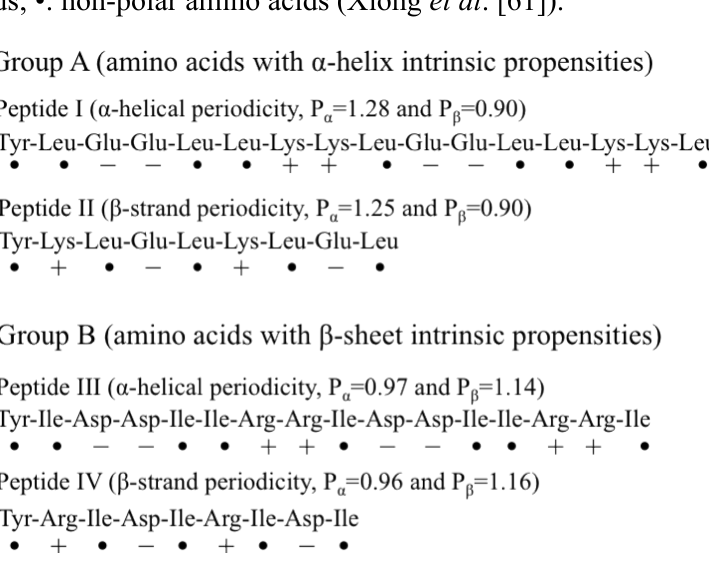
Figure 4. Group A is composed of amino acids with α -helix intrinsic propensities and Group B is composed of amino acids with β -sheet intrinsic propensities. + and − : Polar amino acids; •: non-polar amino acids (Xiong et al .